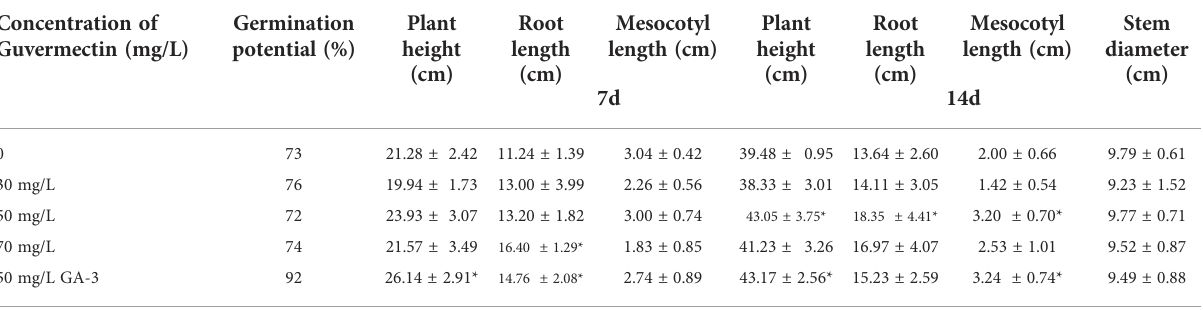
TABLE 2 The effects of guvermectin treatment on the maize seedlings growth in fi eld condition at seedling stage. Concentration of